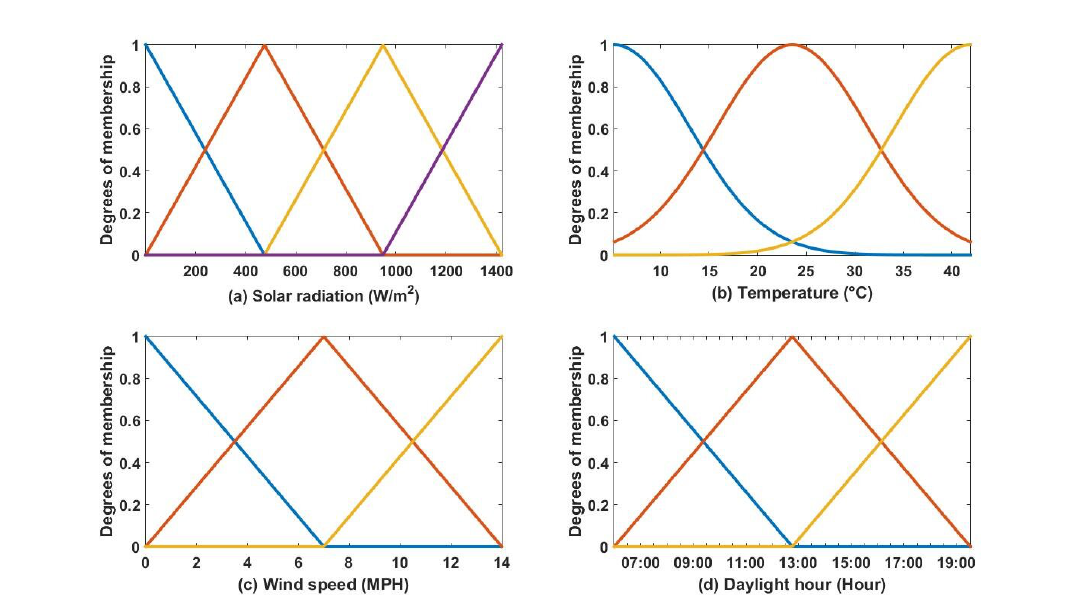
Figure 3. Membership functions for ANFIS: ( a ) Triangular for solar radiation; ( b ) gaussian for temperature; ( c ) triangular for wind speed; ( d ) triangular for daylight